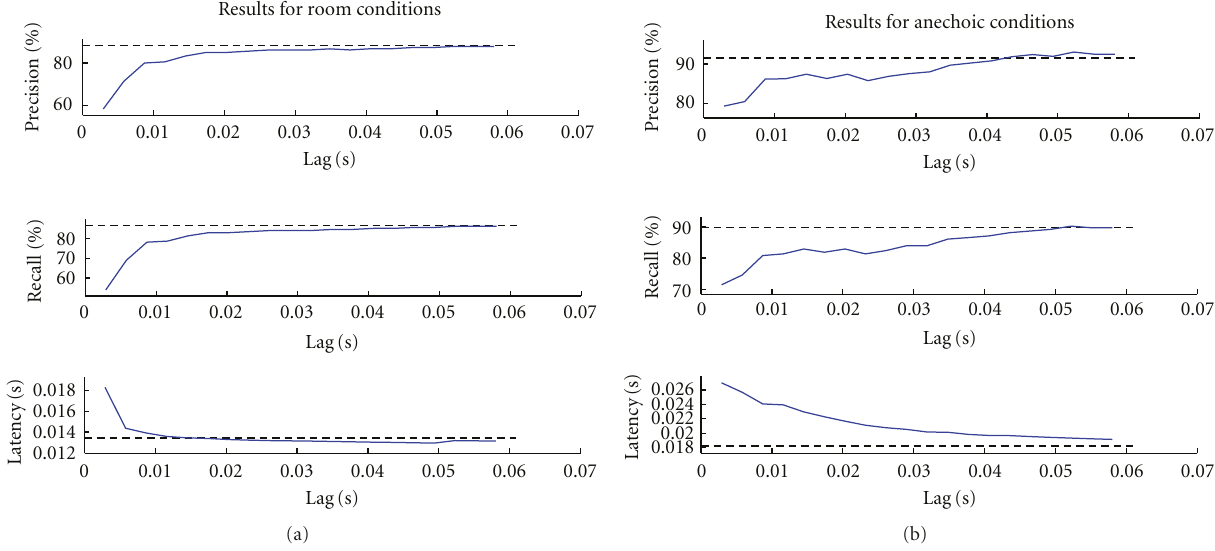
Figure 6: Comparison of algorithm performance between (a) normal room conditions and (b) anechoic conditions. The dashed line indicates o ffl ine